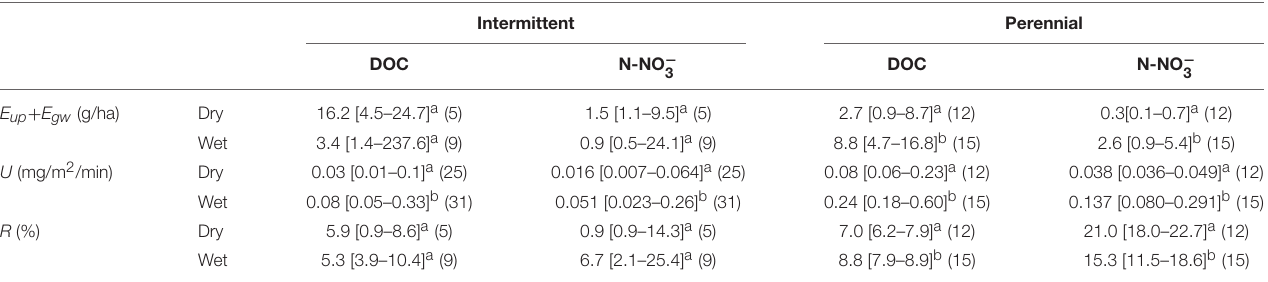
TABLE 4 | Median [25th, 75th percentiles] of solute supply from upstream and riparian groundwater ( E up + E gw ), in-stream demand expressed as areal uptake rates ( U ), and in-stream retention ( R ) for dissolved organic carbon (DOC) and nitrate (NO − 3 ) during individual storms at Fuirosos (2000–2002) and Font del Regàs